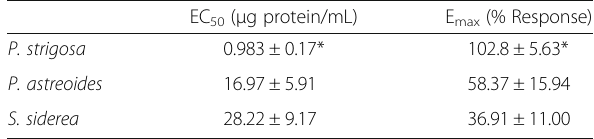
Table 2 Hemolytic activity of the aqueous extracts in rat and human erythrocytes expressed as HU 50 ( μ g protein/mL)